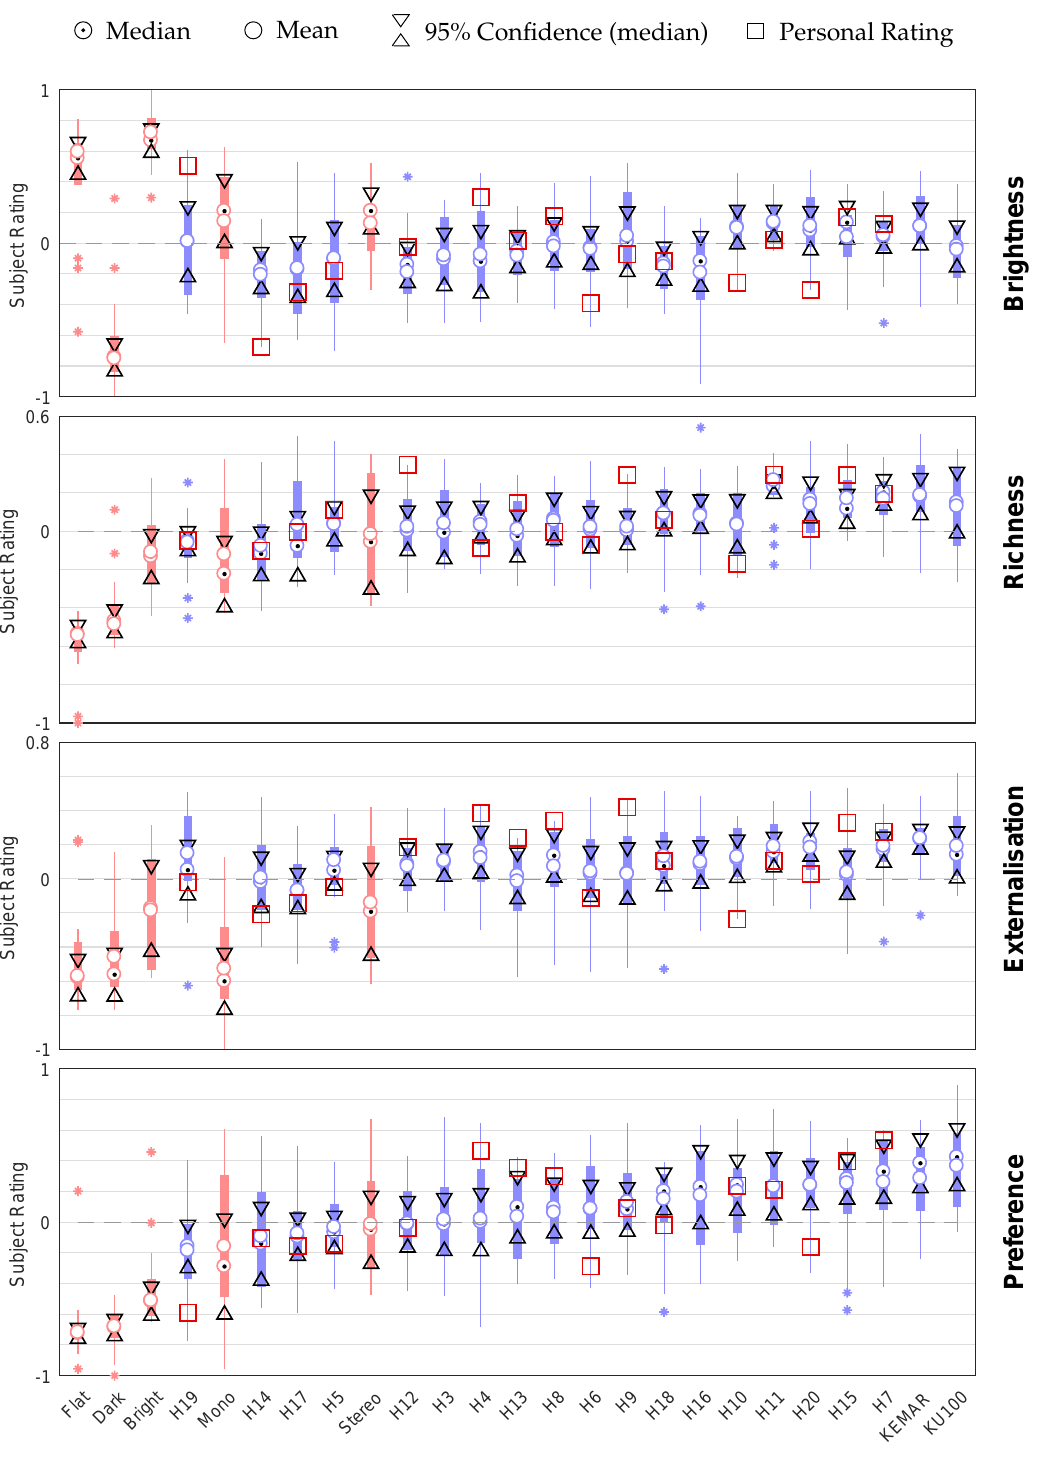
Figure 10. Subject ratings of stimuli in order of mean preference. A personal rating reflects a subject’s rating of their own